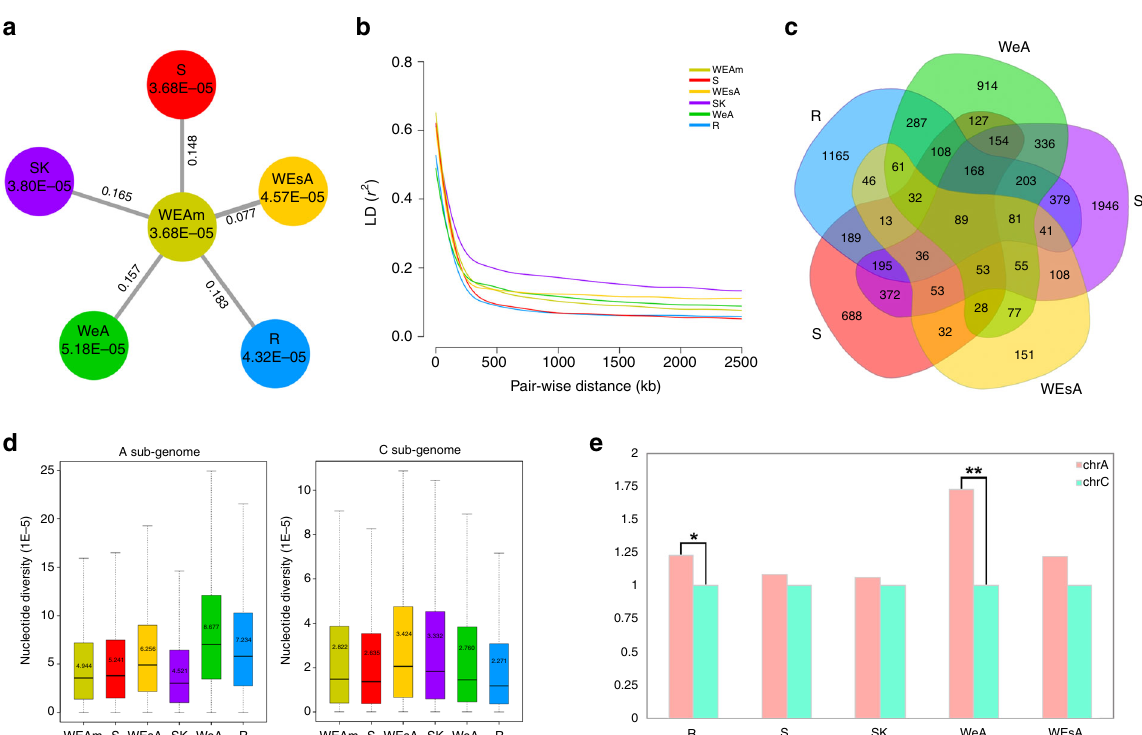
Fig. 3 Comparison of different B. napus genetic clusters. a Nucleotide diversity and F ST across six genetic clusters. The value in each circle shows nucleotide diversity for this cluster; the value on each line represents the F ST between WEAm and another cluster. b Decay of linkage disequilibrium (LD) in each genetic cluster measured by r 2 . c Venn diagram of differentially expressed genes (DEGs) between WEAm and other genetic clusters. d Nucleotide diversity in each genetic cluster based on separated A and C sub-genomes. The box represents the interquartile range. Band inside each box represents median. Number inside each box represents the mean value. The whiskers represent the minimum and maximum values. e The ratio of (DEGs in A sub-genome)/ (DEGs in C sub-genome). * p -value < 0.05 ( χ 2 test); ** p -value < 0.01 ( χ 2 test). 372,546 SNPs were used for all the analysis in a , b , d . Source data of Fig.